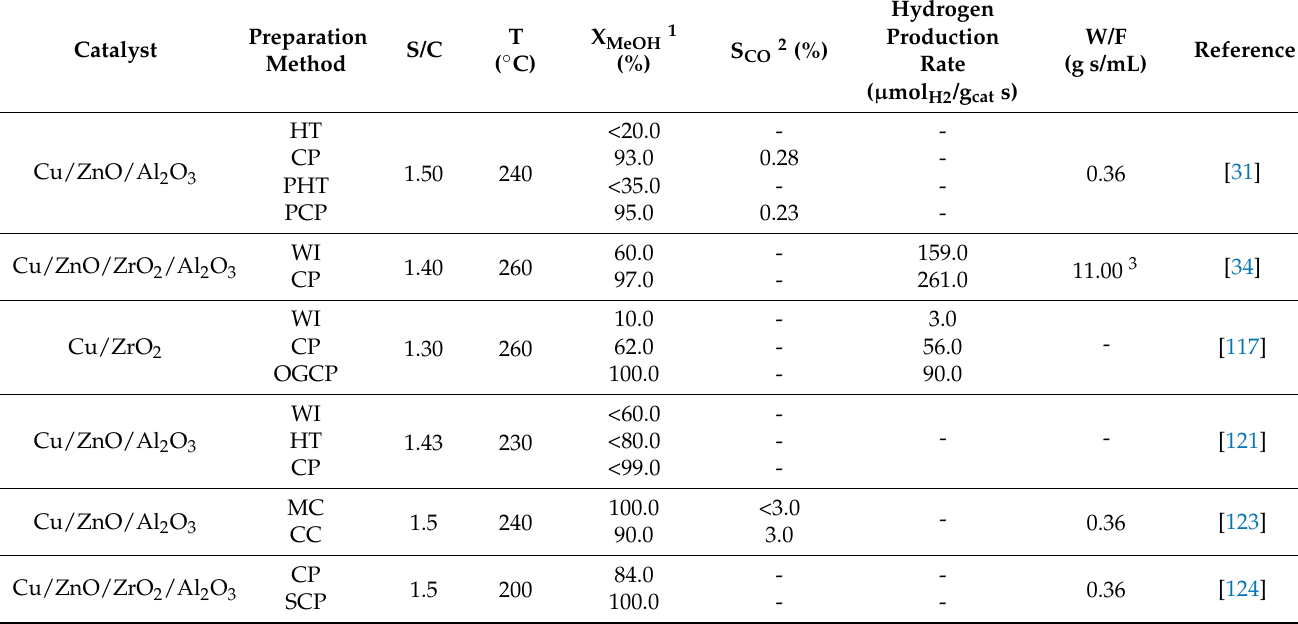
Table 3. Influence of various preparation methods on the performance of Cu-based